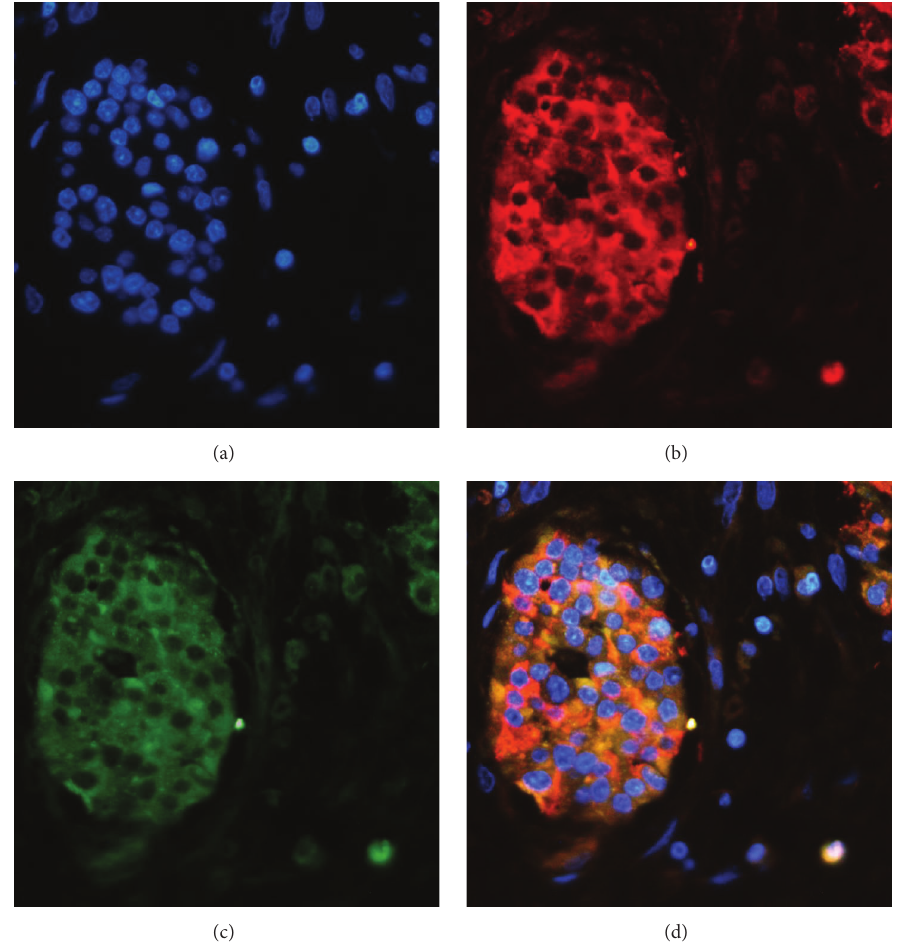
Figure 1: HERG channel proteins expressed in human pancreatic islets. (a) Cell nuclei were stained with DAPI and are illustrated in blue. (b) Insulin immunoreactive cells (red) in the same islet. (c) HERG protein-positive cells (green) in the same islet. (d) Colocalization of insulin and HERG